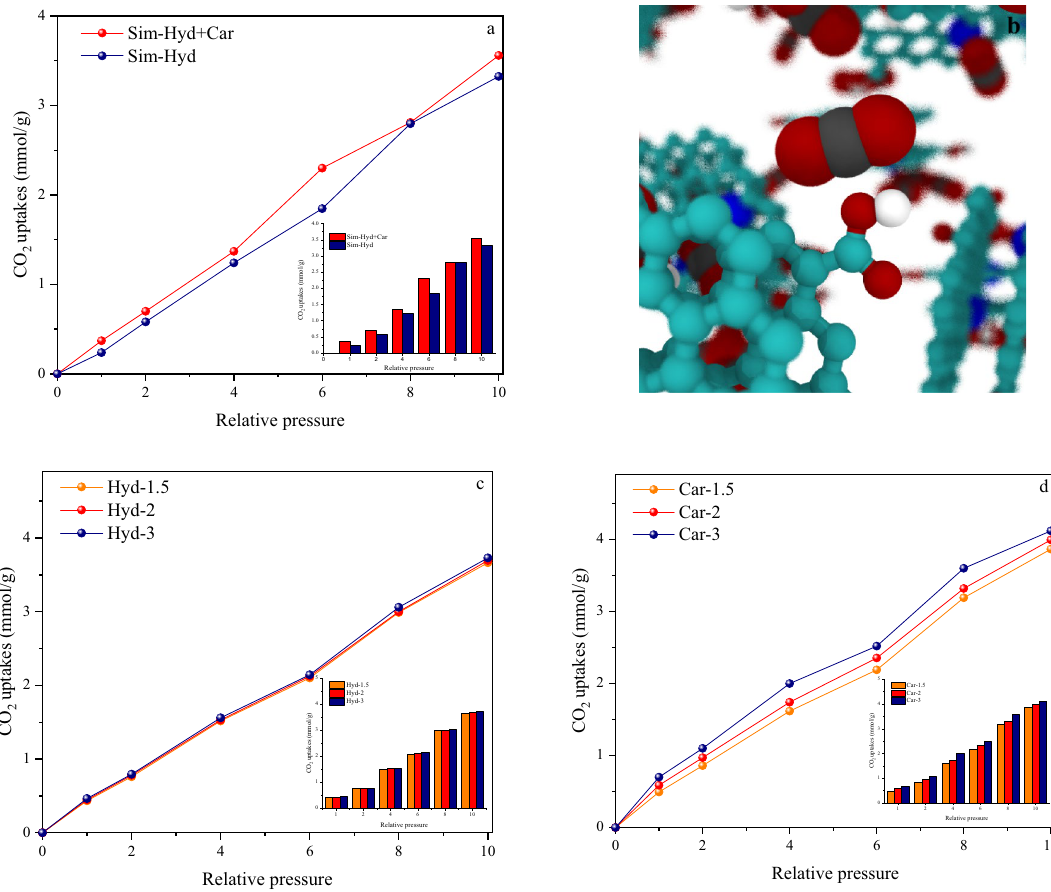
Figure 6. ( a ) Comparison of isotherms simulation at 298 K under pressure range of 0–10 bar within the presence of carboxylic group and without it; ( b ) Snapshot of CO 2 capture in typical functional group (carboxylic group) present in simulated carbonaceous materials; CO 2 molecule (Red–black); ( c , d ) The amount of CO 2 capture in different proportions of hydroxyl and carboxyl groups at 298 K under pressure range of 0–10